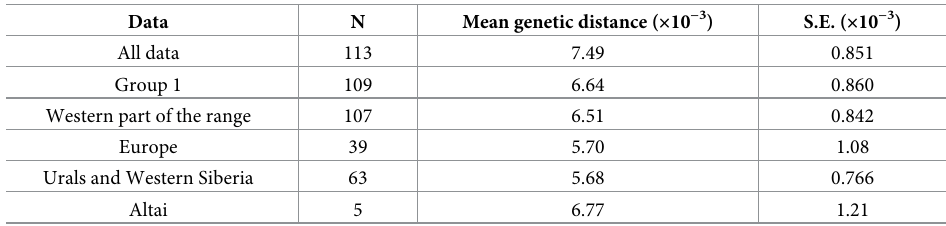
Table 3. Within-group genetic distances of concatenated sequences of A . agrarius